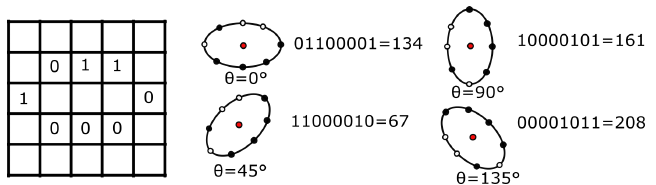
Figure 9. Spatial rotation in an ellipse topology resulting in different decimal values. The decimal value is calculated in a clockwise